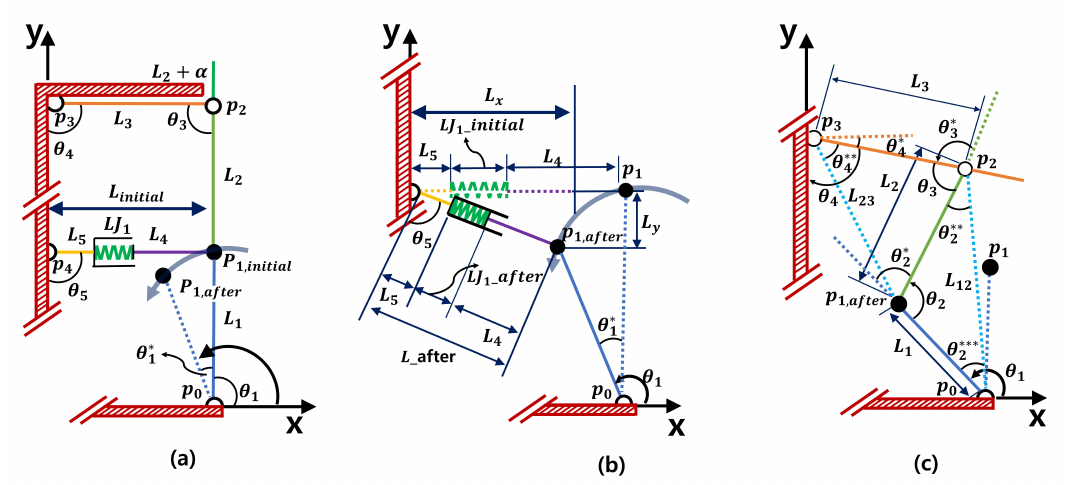
Figure 8. Kinematic model of the proposed self-adaptive gripper. ( a ) Link L 1 movement ( b ) Links L 4 and L 5 movements. ( c ) Links L 1 , L 2 , and L 3